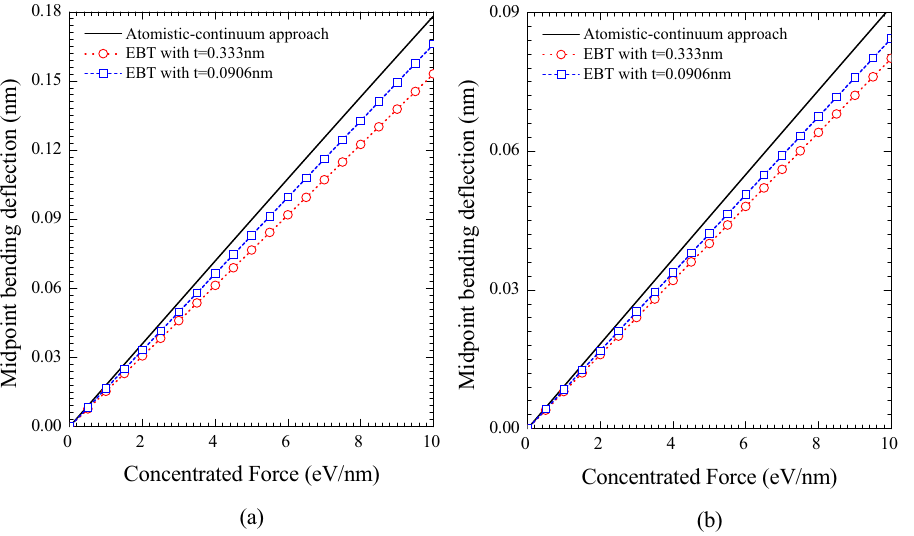
Figure 7: The midpoint bending de fl ection of 10 nm long ( 8, 8 ) ( a ) and ( 10, 10 ) ( b ) BNNTs with clamped constraint versus external transverse